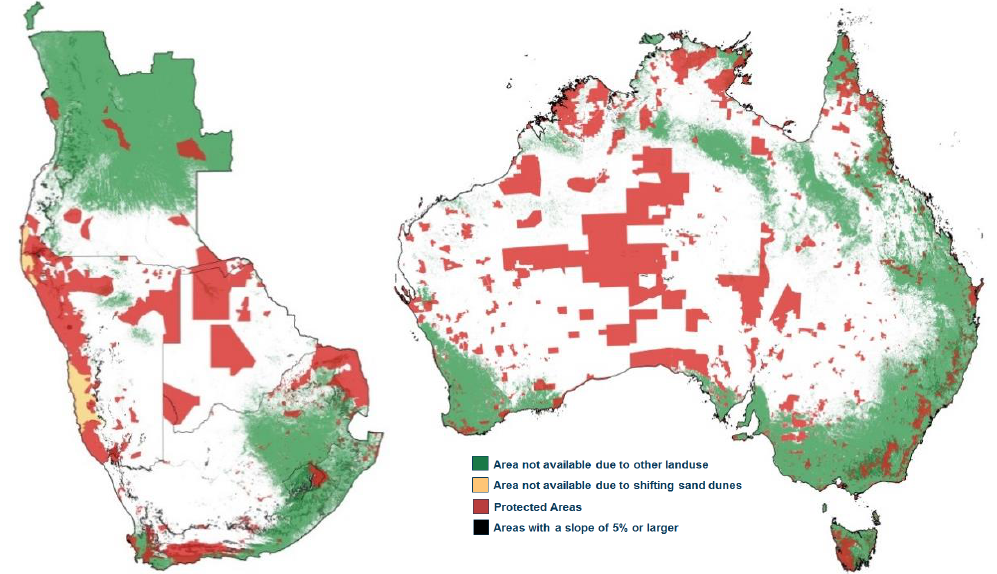
Figure 6. Suitable areas for solar thermochemical fuel production ( white ) in South Africa, Namibia, Angola and Botswana ( left ) and in Australia ( right ). Excluded areas comprise other land use ( green ), protected areas ( red ), ≥ 5% slope ( black ), and shifting sands ( yellow ).